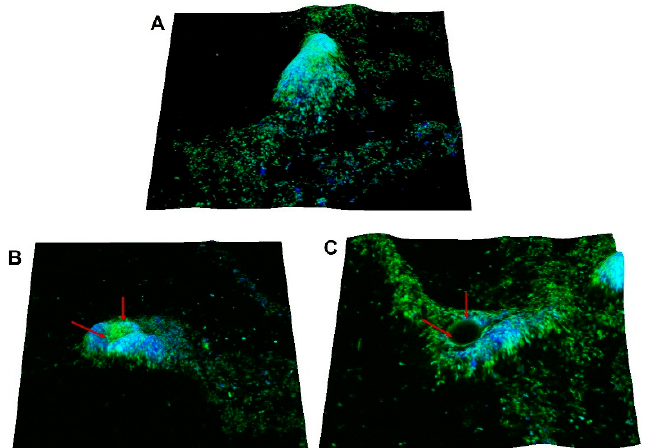
Figure 6. Void formation indicative of biofilm dispersion after exposure C. jejuni 11168-O biofilm to ex-c-di-GMP. ( A ) Representative CLSM images of biofilm grown for 48 h untreated (control). ( B , C ) Biofilm after exposure to 200 μ M ex-c-di-GMP. Calcofluor White (CFW) (green, polysaccharides) and DAPI (blue, DNA). Red arrow indicates central hollowing of microcolony (Scale bar = 10 μ m).